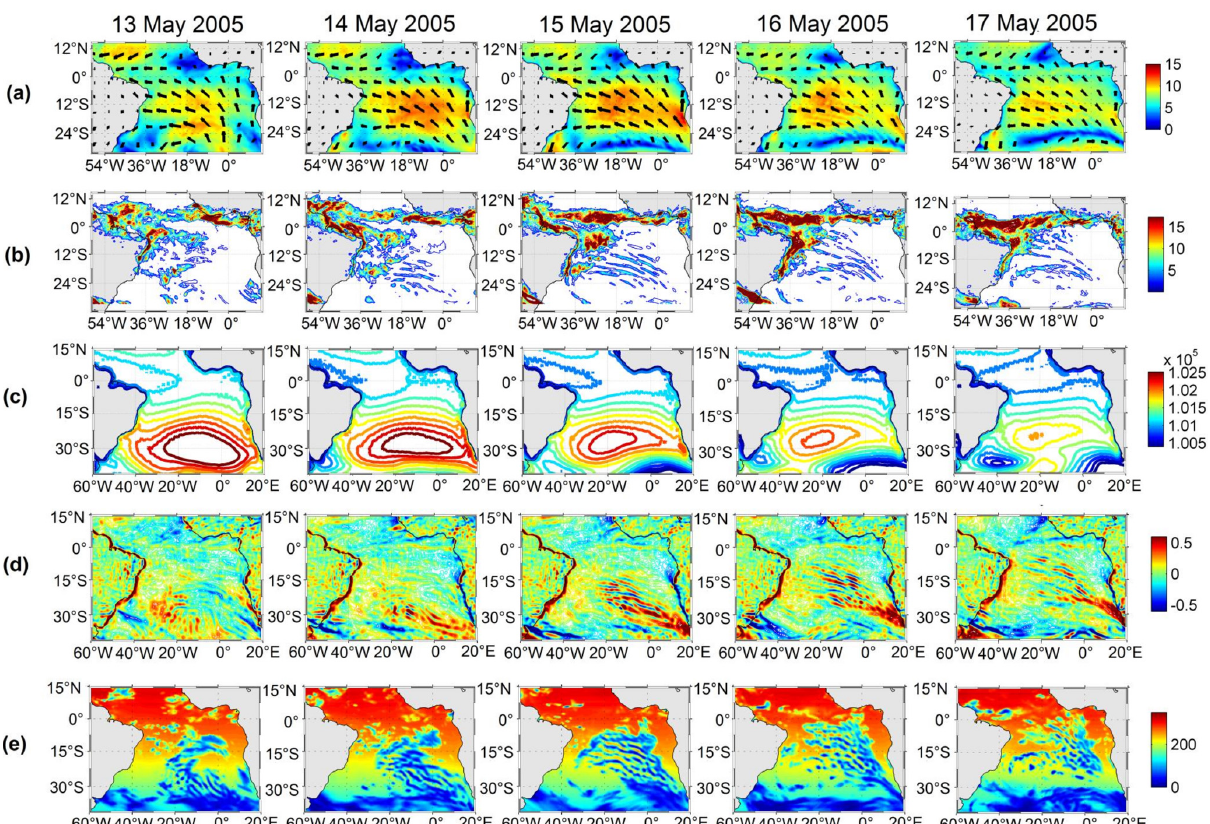
Figure 10. Daily average, from 13 to 17 May 2005 (left to right panels), of (a) wind magnitude (color field) (ms − 1 ) superimposed with wind vectors from CFSR fields, (b) precipitation rate (kgm − 2 day − 1 ) from CFSR fields, (b) surface pressure (hPa) from ERA-20C reanalysis, (c) wind speed curl (ms − 1 ) computed from CFSR wind speed fields, and (d) downward shortwave radiation (Wm − 2 ) from CFSR